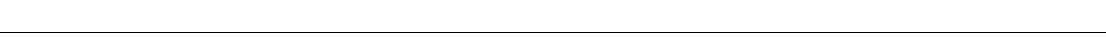
Fig. 3 Characterization of a 3D B cell follicular organoid to model the GC reaction. a Scheme of 3D B cell follicular organoid fabrication. Splenic B cells are co-encapsulated with 40LB stromal cells and IL4 into an RGD-presenting nanocomposite hydrogel that contain gelatin ionically cross-linked with synthetic silicate nanoparticles. b Representative fl uorescence pictures of splenic GFP B cells in 3D organoid culture. c Flow cytometry plot of a 3D B cell follicular organoid. The gated area on the top shows the live B cells (B220 + DAPI − ) and on the bottom plot, the organoid GC B cells (GL7 + FAS + ) within live B cells. d Average of GC B populations of organoids quanti fi ed as in c . e Average of percentage of proliferating organoid GC B populations, quanti fi ed